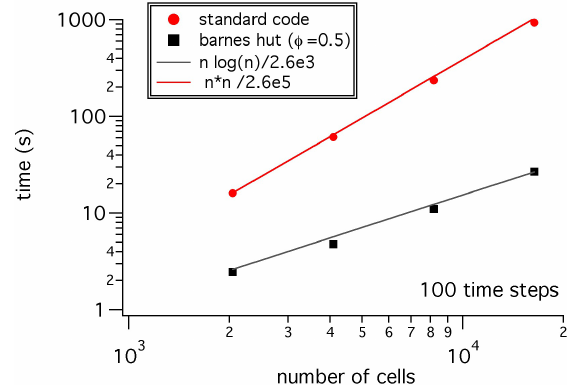
Fig. 5. Scaling of execution time with number of elements for nu- cleation with the Barnes-Hut scheme for φ =0.5 (black symbols), and with the standard method (red symbols) for 100 time steps. Shown for comparisons are lines following N 2 and N log N